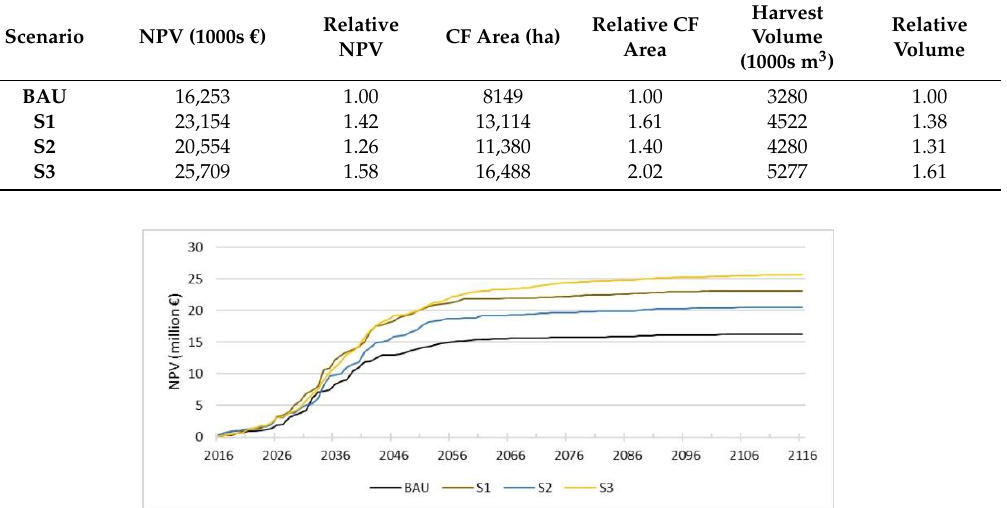
Figure 6. Annual harvested volume per hectare ( top-left ), standing volume ( top-right ), harvested sawlog volume ( bottom-left ) and harvested pulpwood volume ( bottom-right ) for the BAU and three global scenarios over the 100-year planning horizon. To show the trends, 10-year average values rather than actual annual volumes are presented. All values are in m 3 ha −1 year −1.